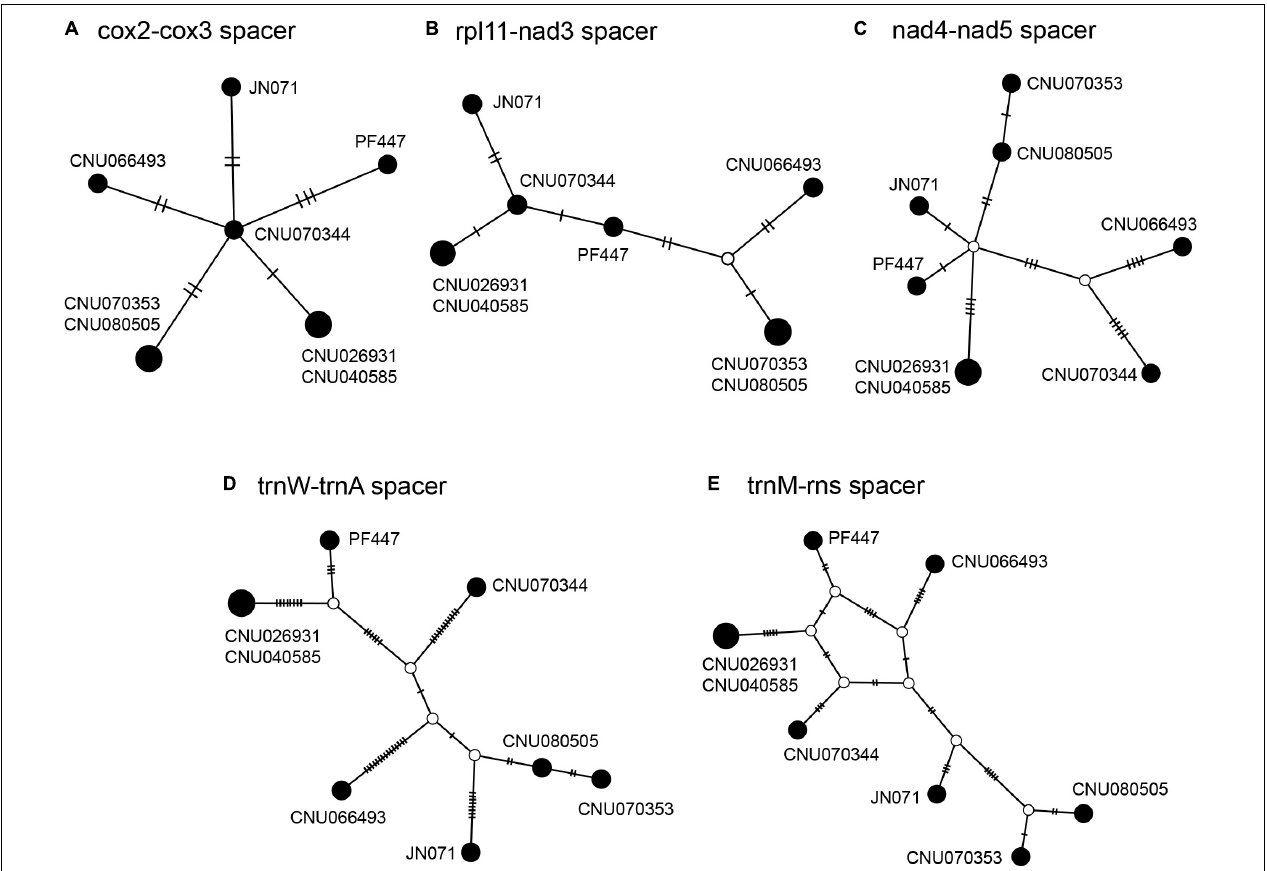
FIGURE 2 | Haplotype networks of five intergenic spacer regions: cox 2- cox 3 (A) , rpl 11- nad 3 (B) , nad 4- nad 5 (C) , trn W- trn A (D) , and trn M-rns (E) . The size of circle is proportional to haplotype frequencies in each network. Each connecting line indicates one mutation step between haplotypes.